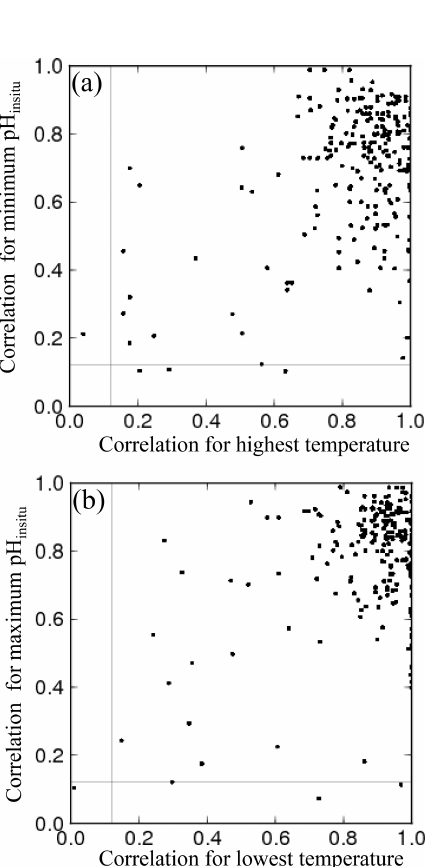
Figure 5. Scatter plots of correlation coefficients for water tempera- ture and pH insitu at adjacent monitoring sites in the same prefecture. Panel (a) shows the highest temperature and the minimum pH insitu , and panel (b) shows the lowest temperature and maximum pH insitu .